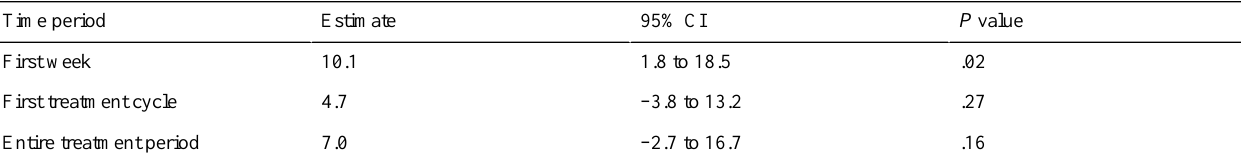
Table 2. Global quality of life score adjusted mean differences between intervention and control groups.